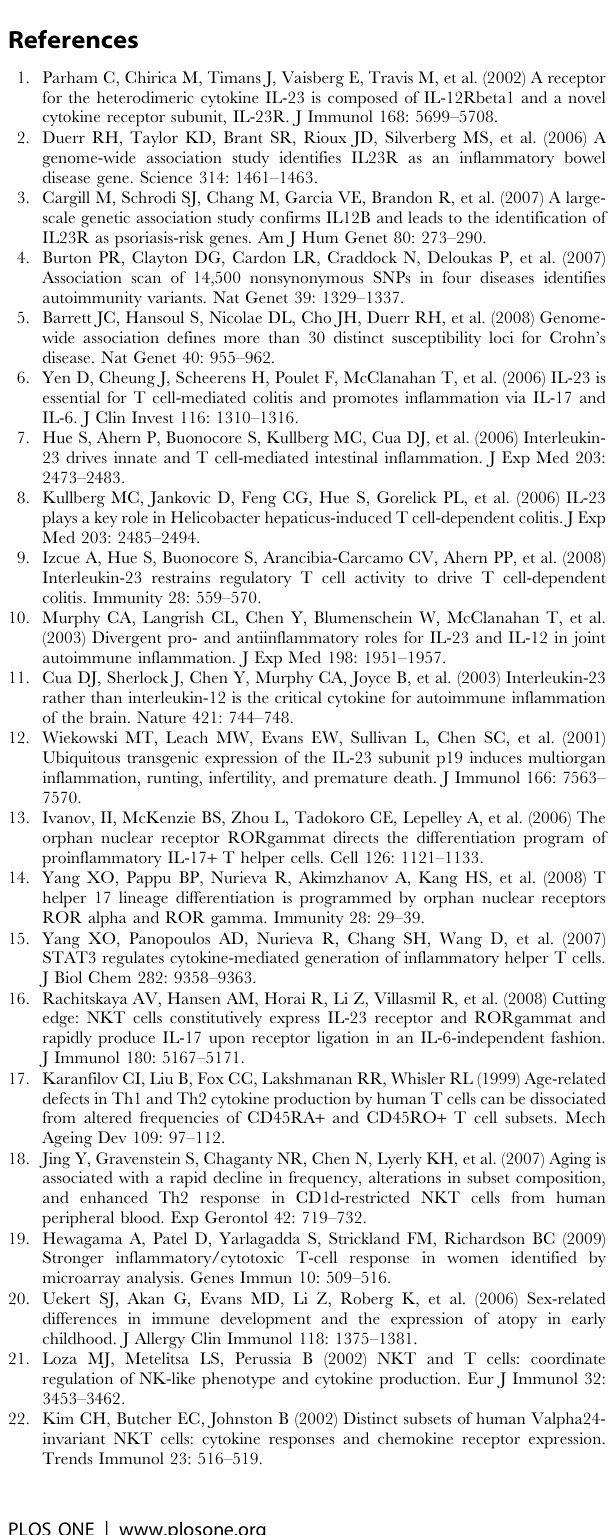
Table S1 Overlap between CD8 + CD45RO + memory T cells, CD3 + CD56 + NKT cells, and CD3 + CD161 + cells in peripheral blood. (PDF)